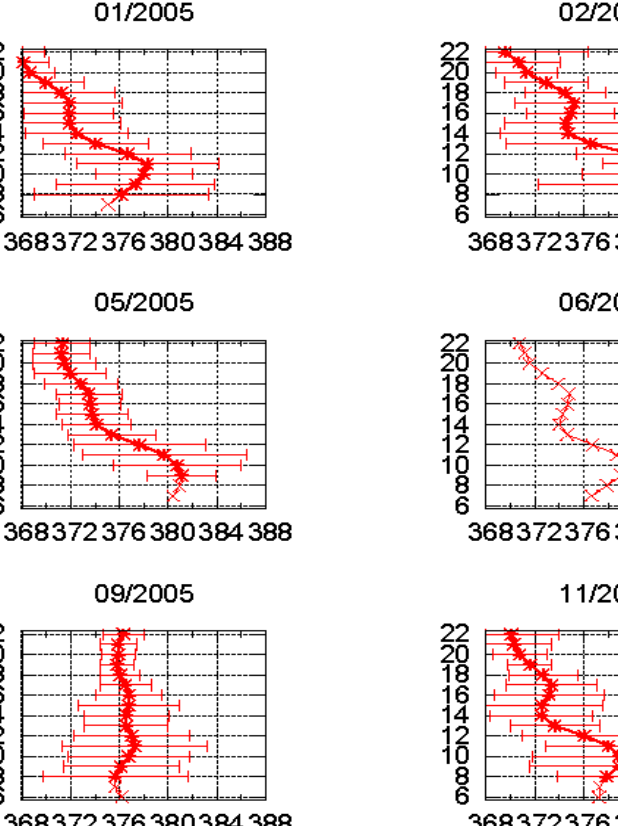
Fig. A1. Monthly mean CO concentration (x-axis in ppm ) evolution with altitude (y-axis in km ) for nine months of 2005 for the 50 ◦ N- 2 60 ◦ N latitude band. Horizontal bars correspond to the standard deviation of retrieved CO indicates that less than 10 occultations were available; in that case, standard deviation is not estimated. Fig. A2. Same as Fig. A1 for 2006